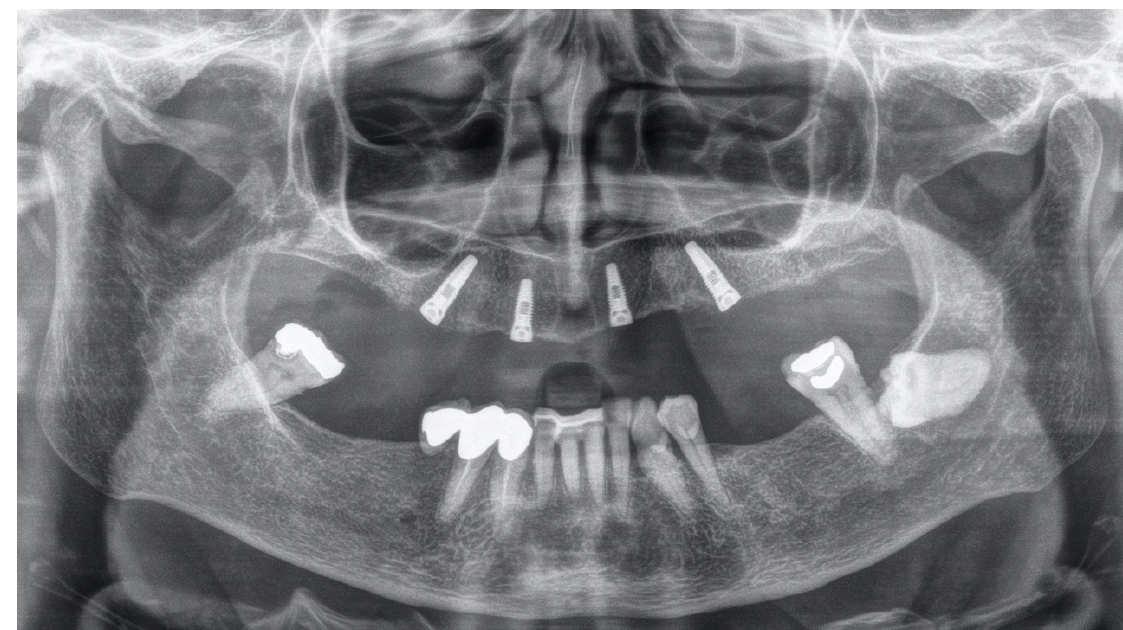
Figure 2. Initial panoramic radiography.